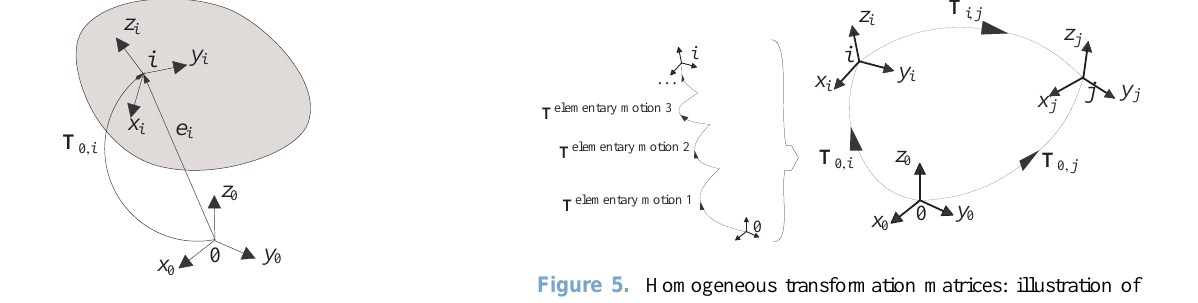
Figure 4. Formalism of homogeneous transformation matrix.